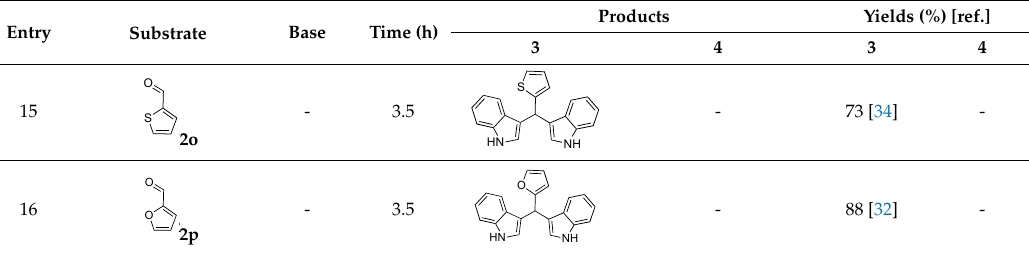
Scheme 4. Proposed reaction mechanism.